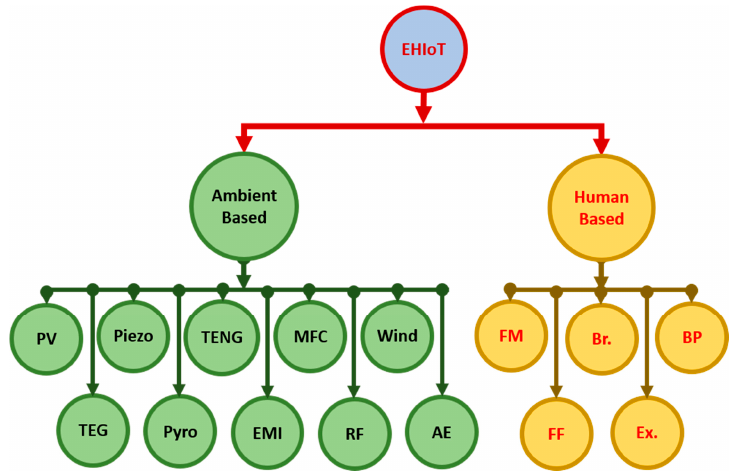
Figure 5. Taxonomy of energy harvesting in IoT (EHIoT).